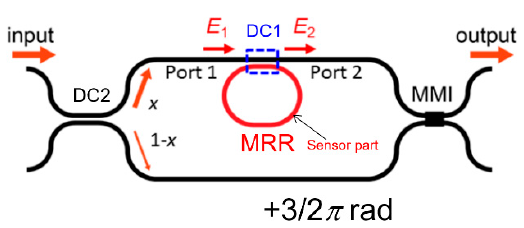
Figure 13. Schematic top view of the silicon-MRR-enhanced Mach–Zehnder interferometer (Si-MRR-MZI) sensor.